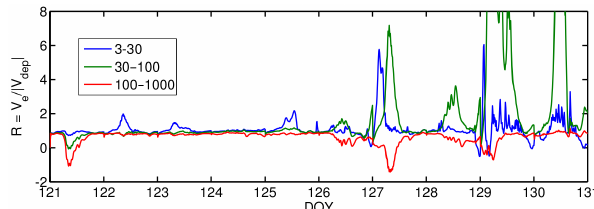
(cid:12) (cid:12)(cid:11) around the (cid:12) V dep